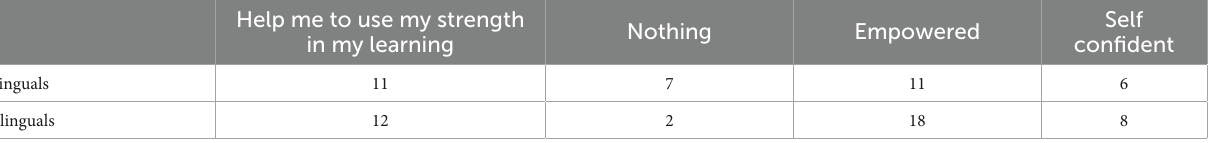
TABLE 5 Themes emerged as an answer to question